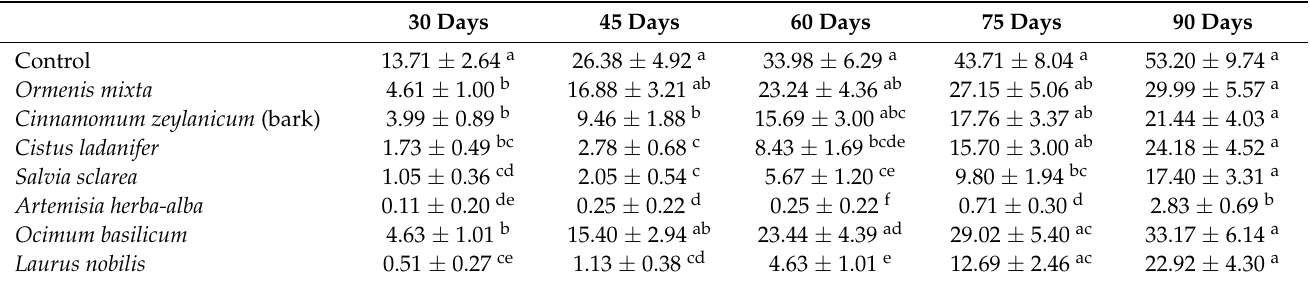
Table 2. Longest sprout length of potato tubers treated with the most effective essential oils and the control at different time